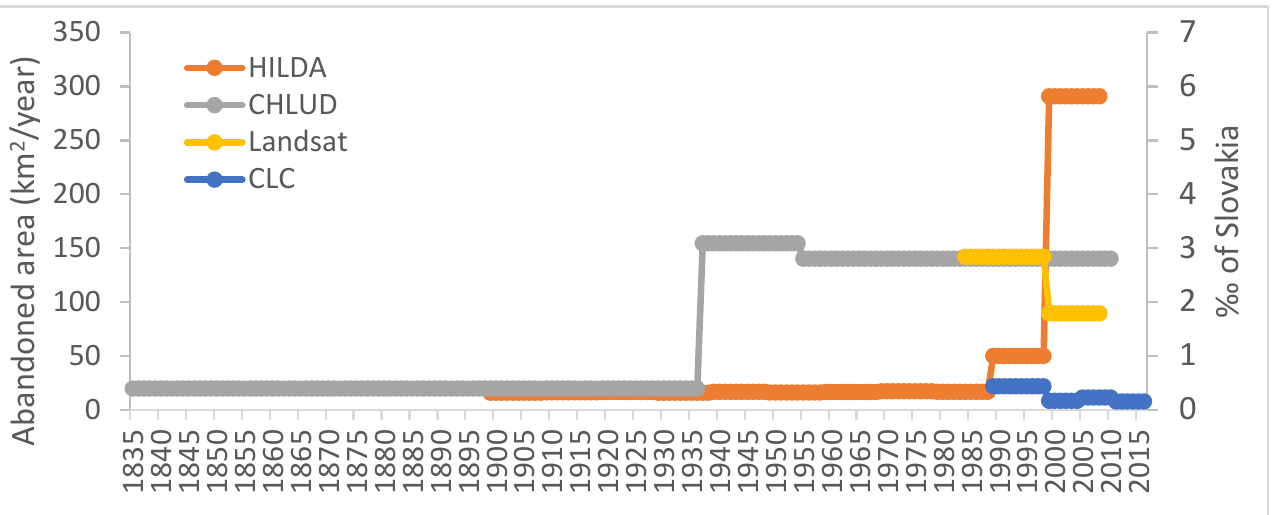
Figure 3. Cropland abandonment rates analysed from the land use/land cover data sources.